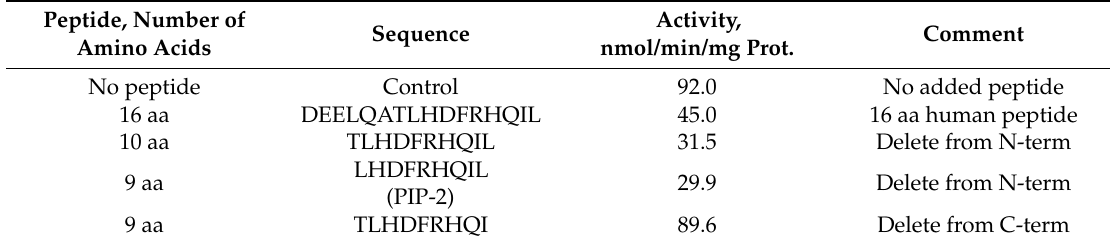
Table 2. Deletion of amino acids from the N- or C-terminus of the 16-aa human-derived SP-A peptide: effect on the inhibition of aiPLA 2 activity of recombinant